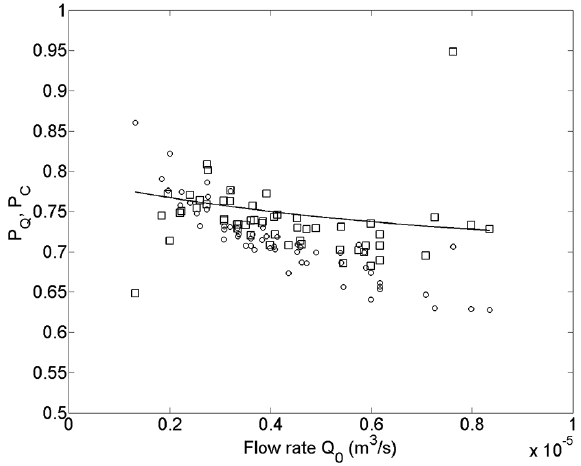
Figure 11. Comparison between the probability of water distribu- tion P Q evaluated by the flow model (straight line) and the proba- bility of particle transition P c (square) and P Q (circle) for ENM4 varying the injection flow rate Q 0 (m 3 s − 1 ).